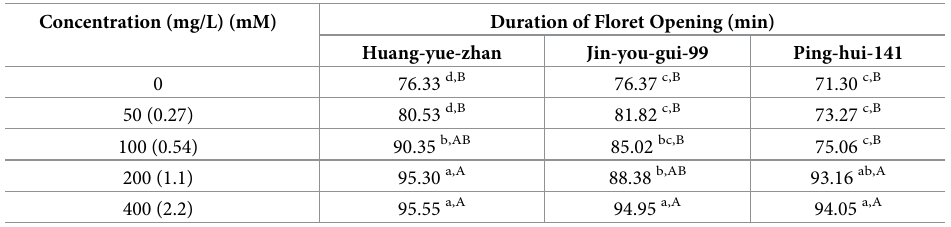
Table 2. NAA regulation of the duration of floret opening in fertile rice.